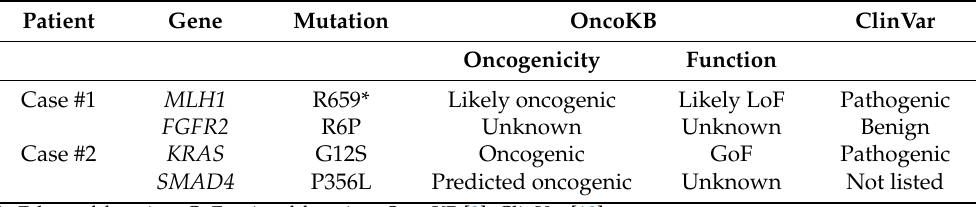
Table 2. Prediction of the biological effects of mutations identified in cases with local recurrence.